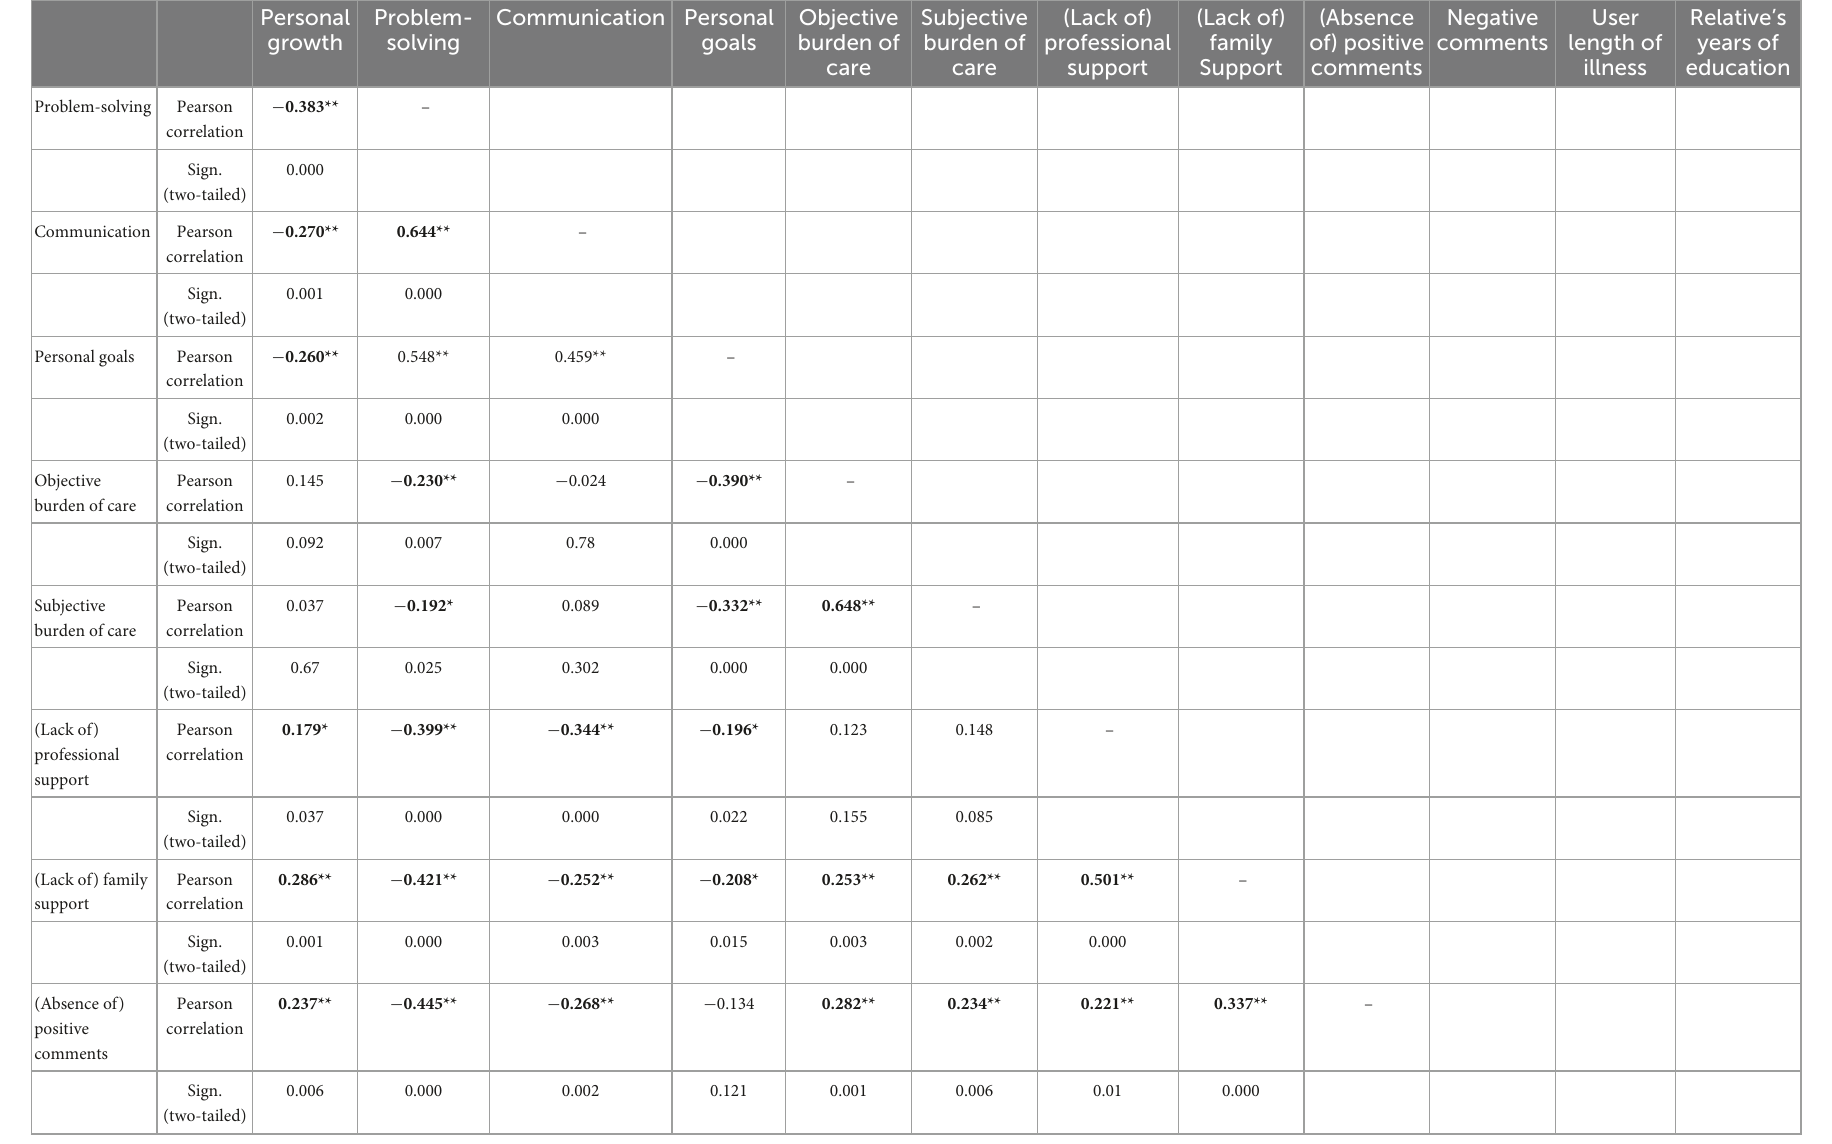
TABLE 5 Correlations between caregivers’ personal growth and the 3 dimensions of FFQ and 6 dimensions of burden of care, as measured by FPQ, and the duration of user illness and relative’s years of